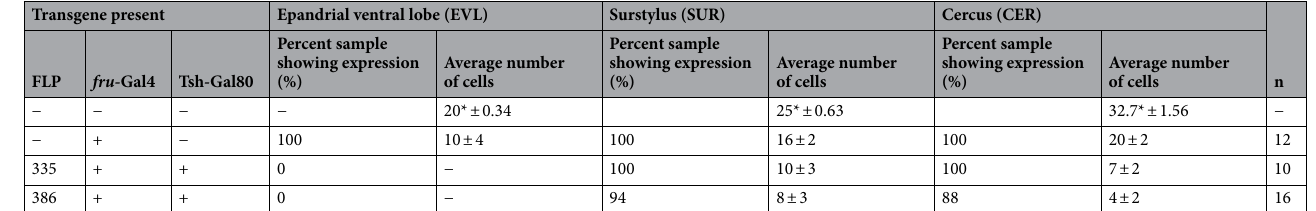
Table 2. Expression summary of the male genitalia of the different genetic combinations. *Based on bristle count published in Taylor 1998.